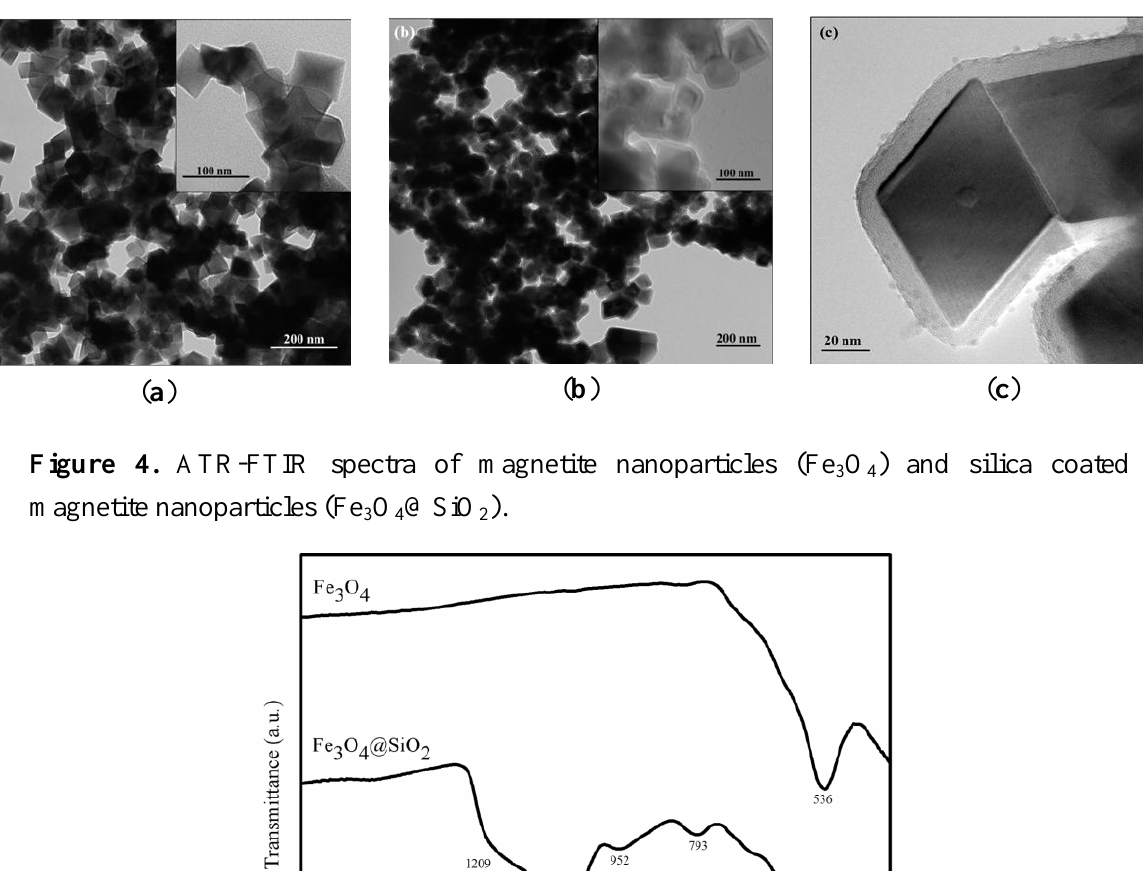
Figure 3. TEM images for magnetite ( a ); and silica coated magnetite ( b , c ) particles.